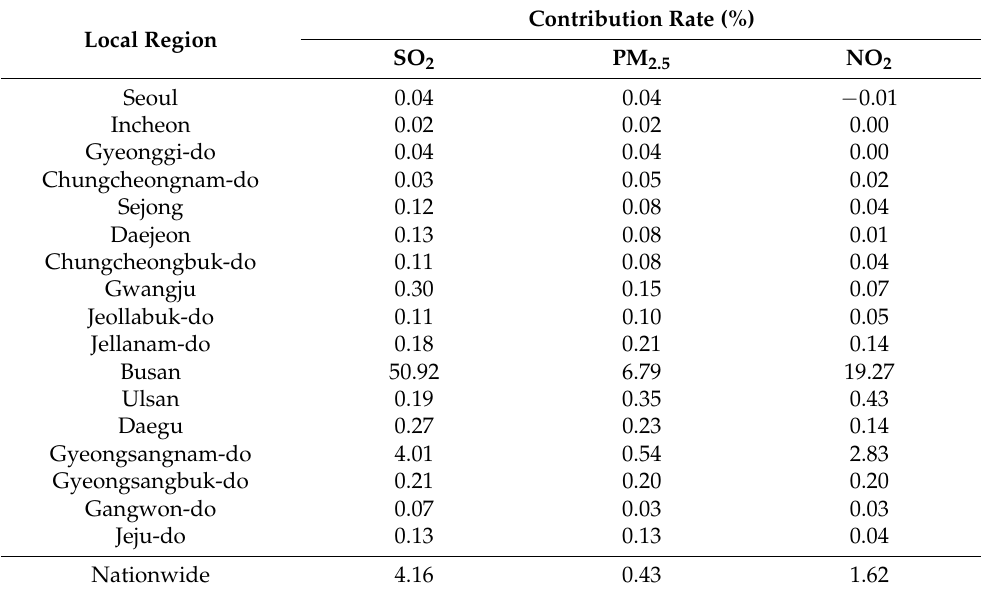
Table 3. Annual contribution rates (%) of SO 2 , PM 2.5 , and NO 2 for each local region from ship emissions from Busan.